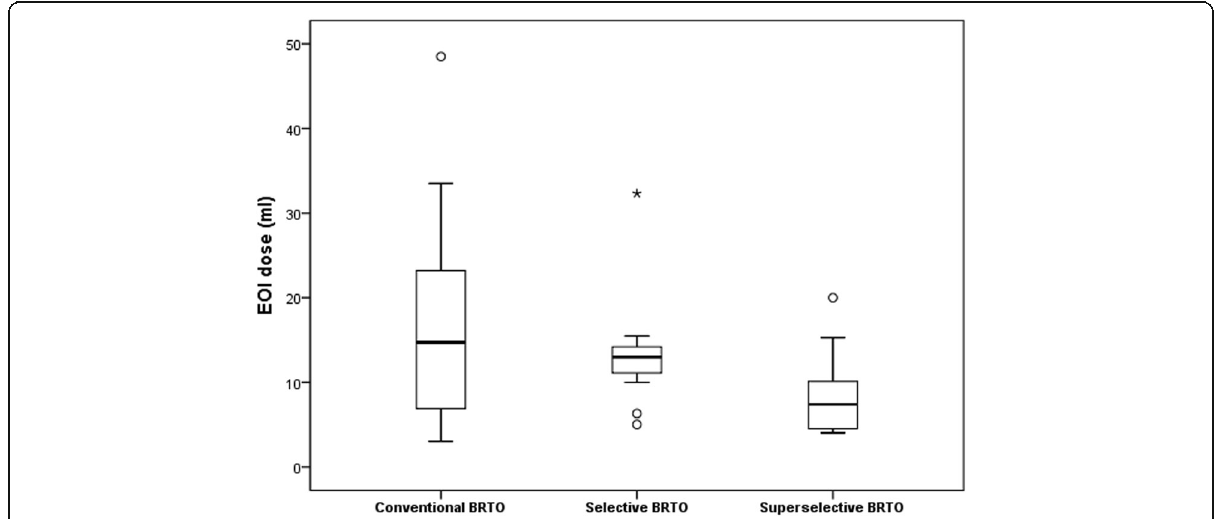
Fig. 5 EOI volume used during different BRTO techniques. Box Plot shows that EOI volume used in superselective BRTO technique was lower than selective BRTO ( p = 0.05) and conventional BRTO ( p =